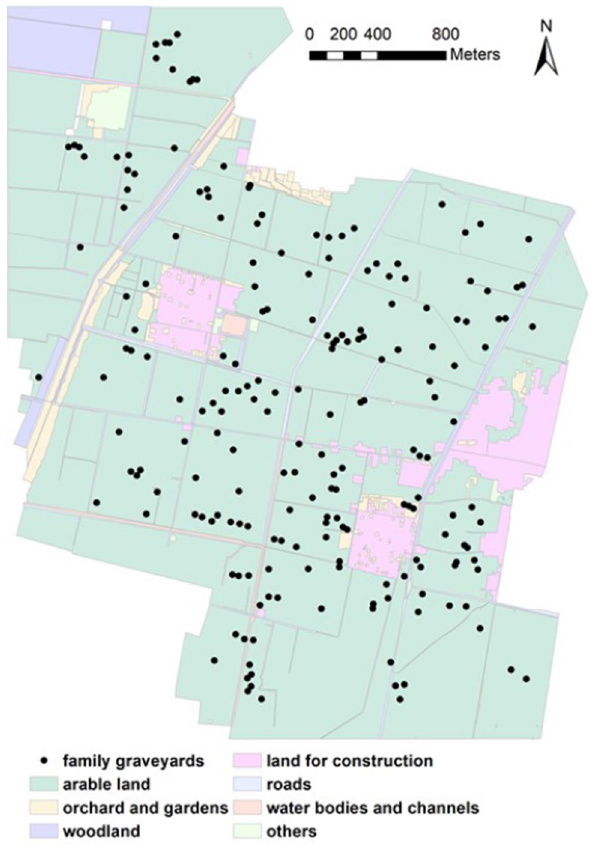
Figure 4. Location of the 199 family graveyards on arable land. ArcGIS10.2 49 was used to create this map. The data of land use and family graveyards location comes from the field survey by the second author of this